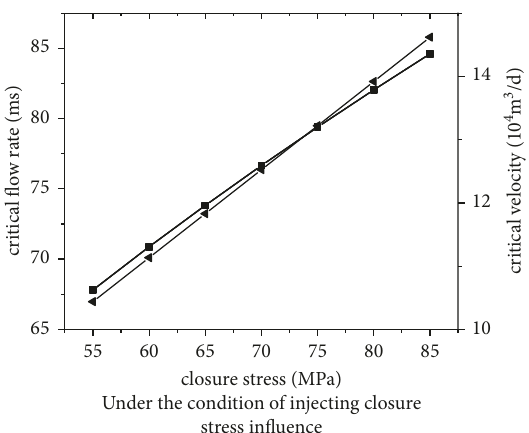
Figure 6: Influence diagram of closure stress under injection condition.